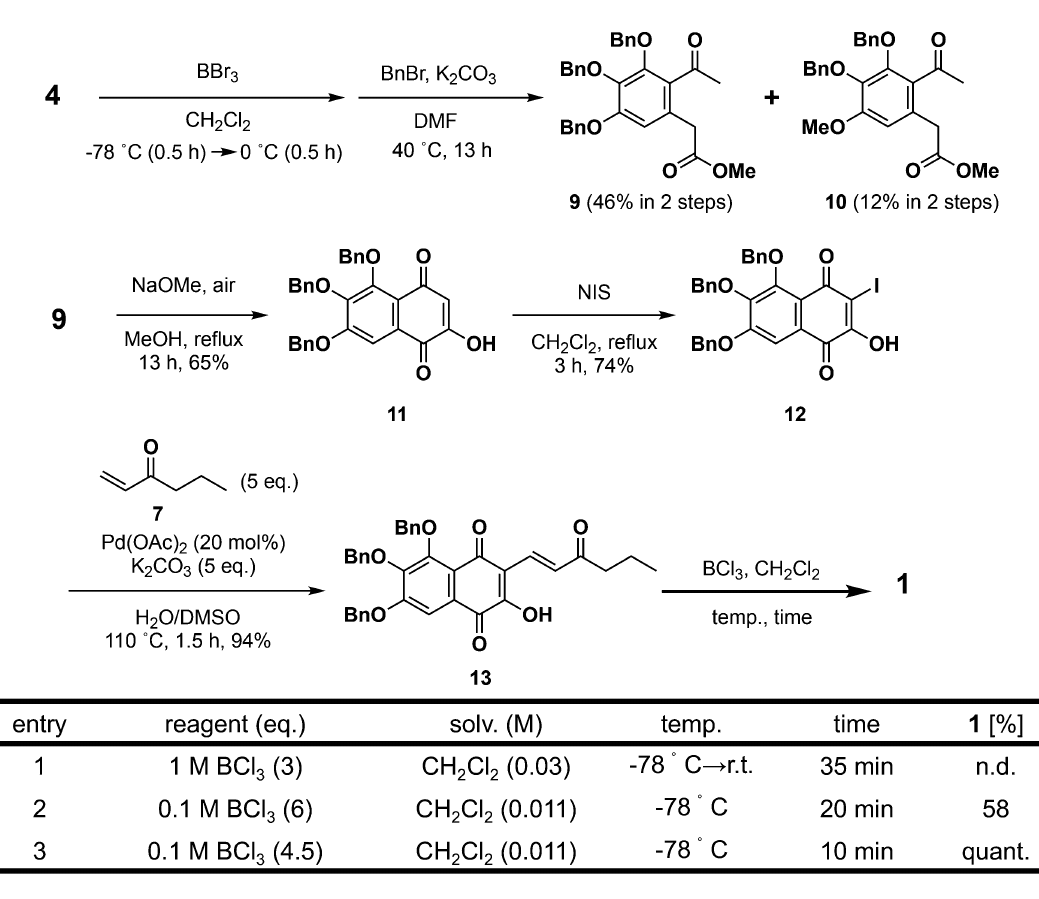
Figure 4. First total synthesis of 1